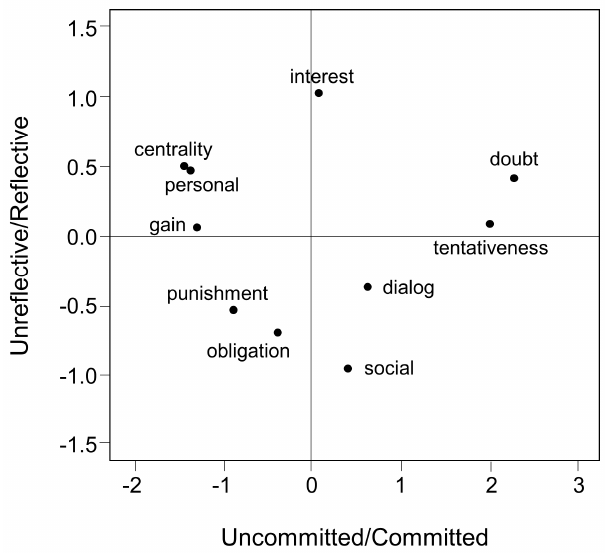
Figure 2. MDS Euclidean distance model of the CROI in the Student sample.